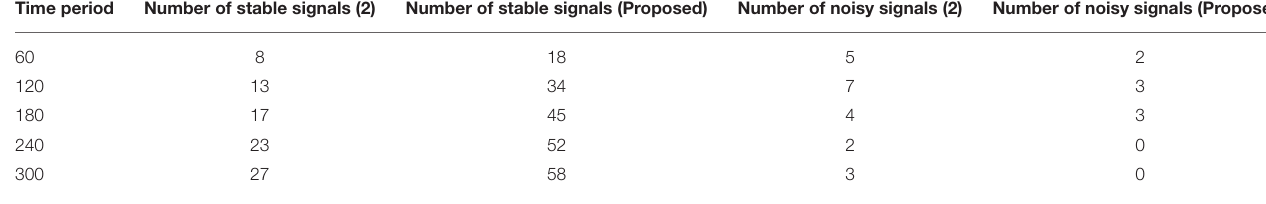
TABLE 1 | Separation of stable and noisy signals.